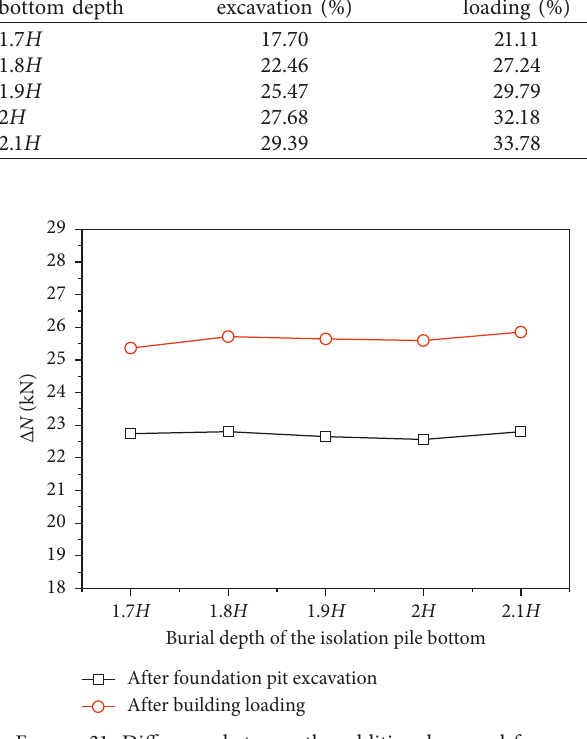
Figure 31: Difference between the additional normal